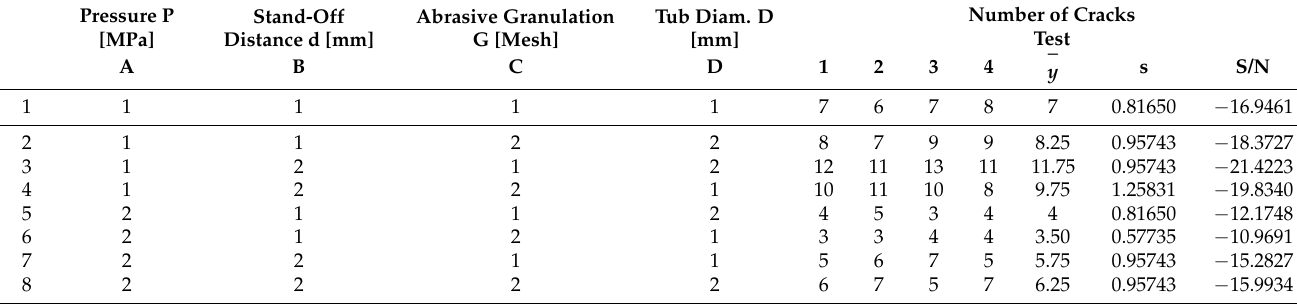
Table 7. Taguchi experiment